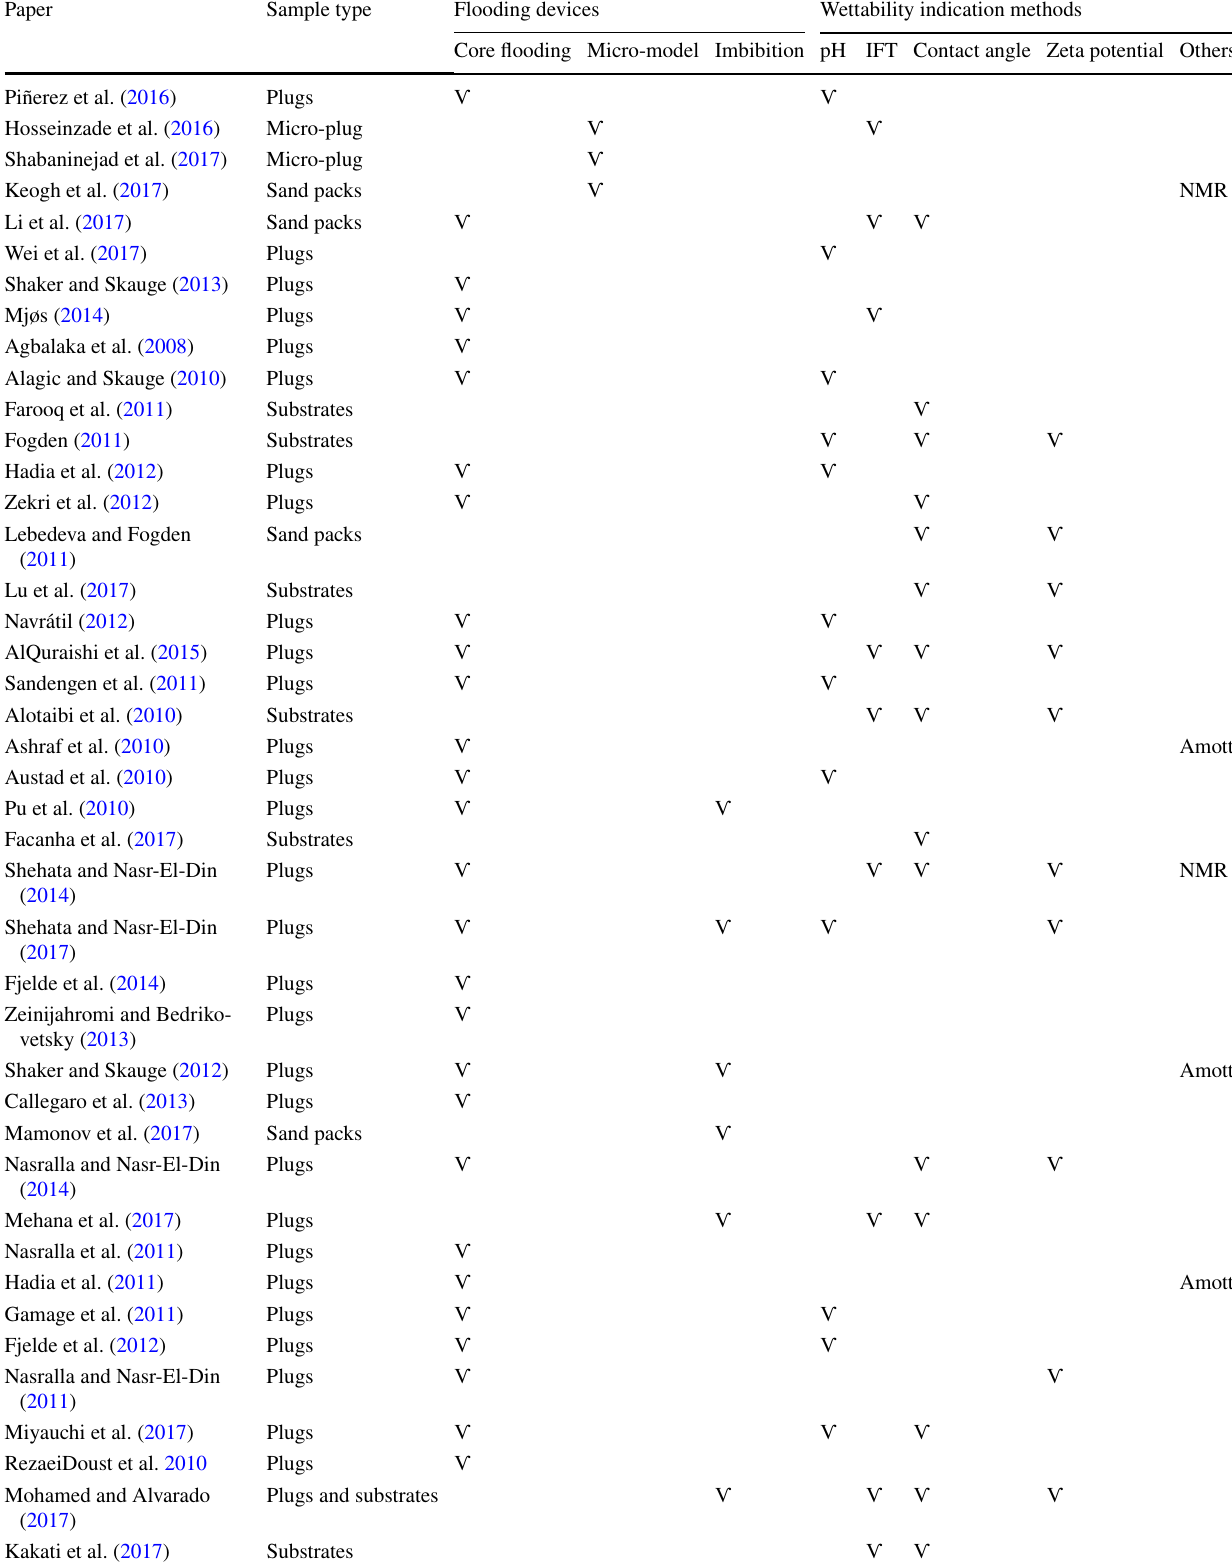
Table 2 Flooding devices and measurement methods of the previous experimental